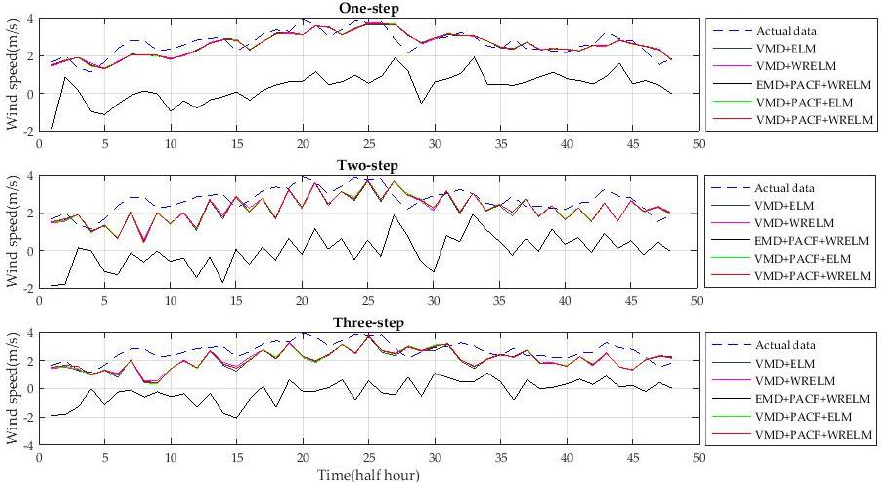
Figure 13. Forecasting results on 20 August 2004, using different methods.